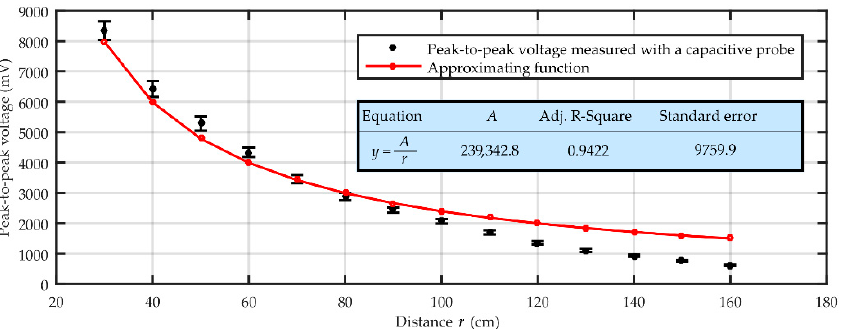
Figure 13. Measured dependence of the amplitude of the voltage signal registered by the capacitive probe on the distance r from the signal source and its approximating function.